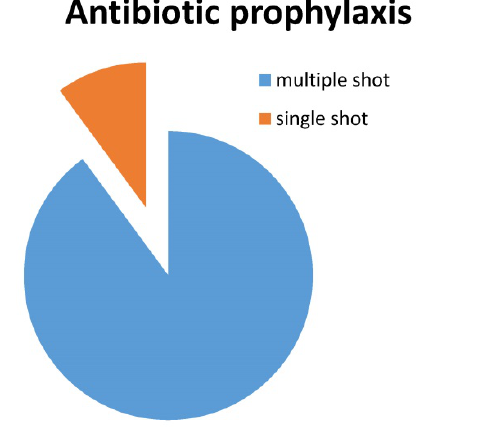
Figure 1. Antibiotic prophylaxis